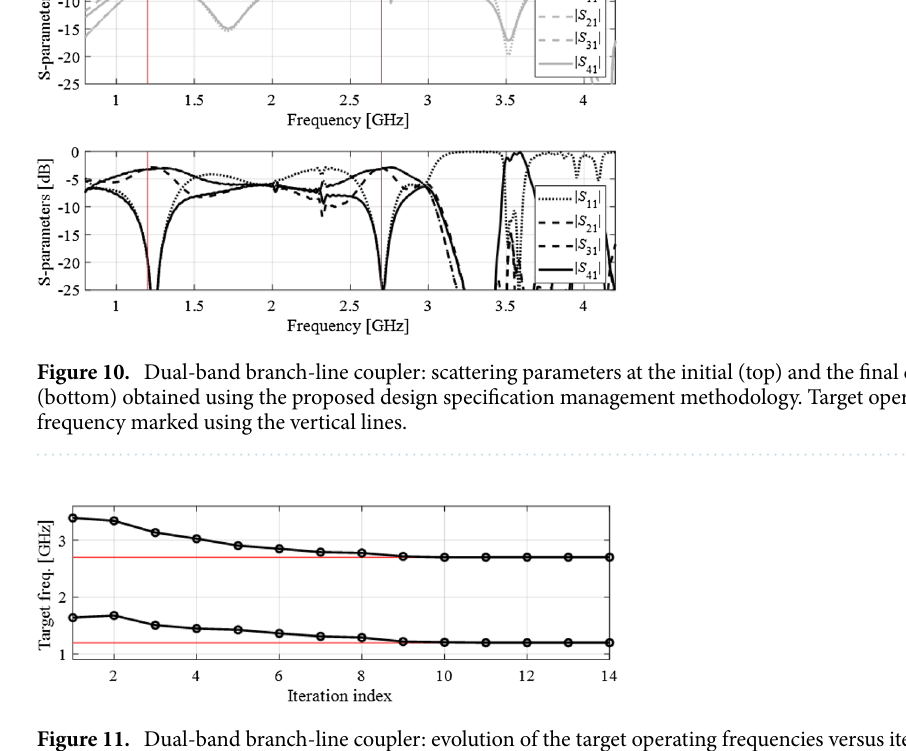
Figure 11. Dual-band branch-line coupler: evolution of the target operating frequencies versus iteration index of the optimization algorithm. Original target frequencies marked using a horizontal